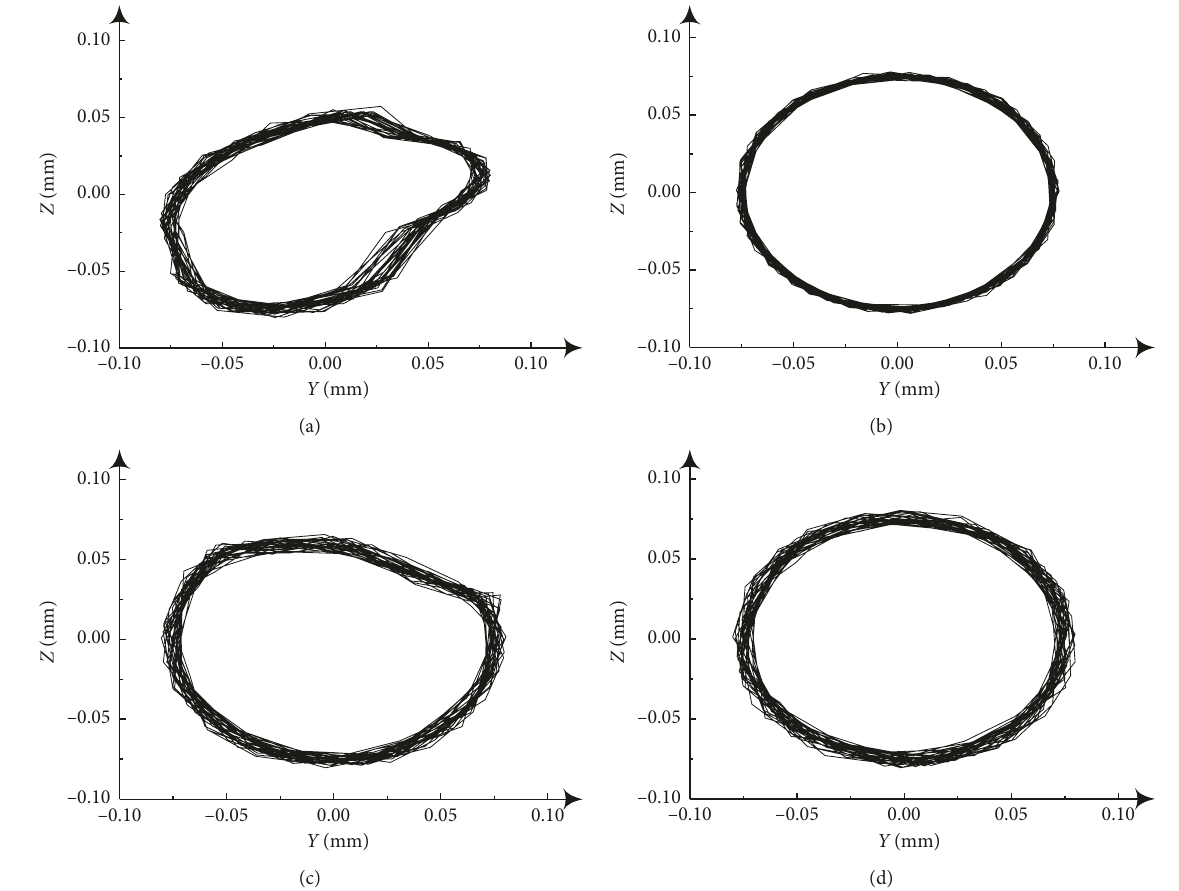
Figure 14: Relative tracks at T � 300K and (a) 15000rpm, (b) 20000rpm, (c) 25000rpm, and (d)